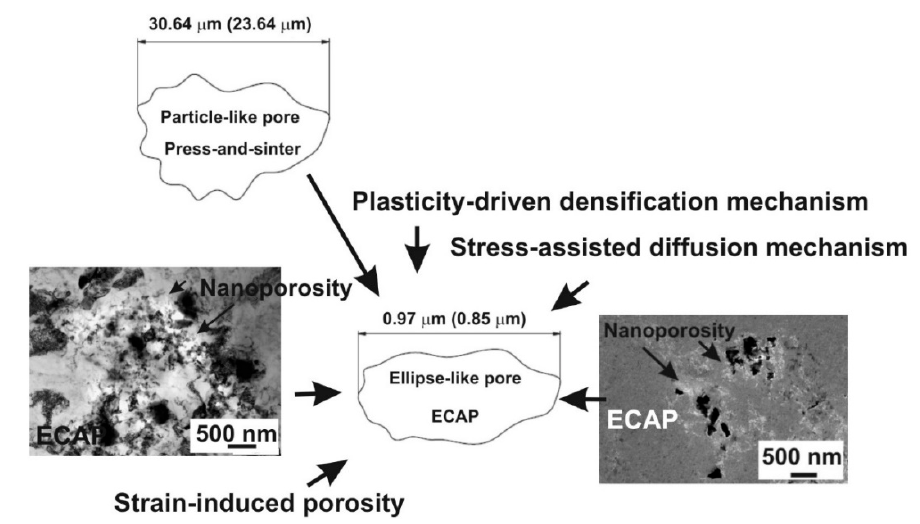
Figure 9. Particle-like pore derived from press-and-sinter process.